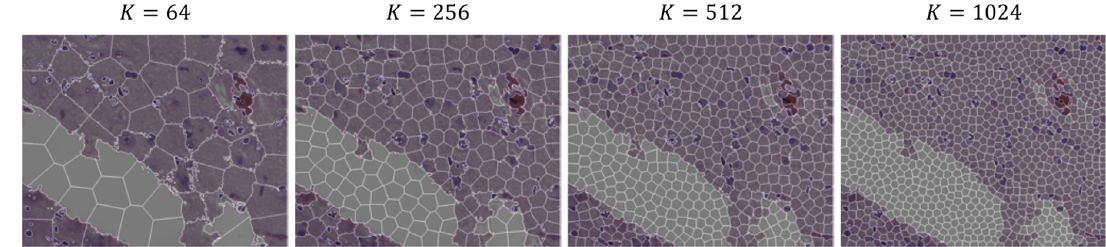
Figure 7. Different SLIC segmentation results depending on the number of target superpixels ( K ).